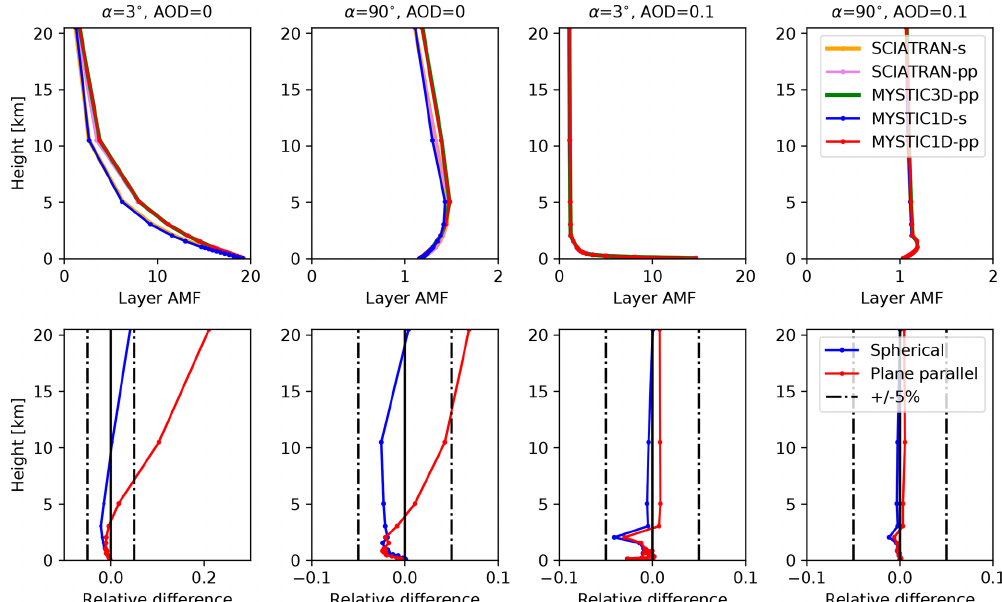
Figure 3. Upper row: MAX-DOAS AMF profiles for MYSTIC 1D spherical geometry (s), 1D plane-parallel geometry (pp) and 3D plane- parallel geometry (pp) for two selected elevation angles of 3 and 90 ◦ , a SZA of 20 ◦ , with and without aerosol for radiation at 577nm. Corresponding profiles computed with the SCIATRAN RTM are shown for comparison. Lower row: profile of relative differences of MYS- TIC and SCIATRAN results in spherical (s) and plane-parallel geometry (pp) (Wagner et al.,